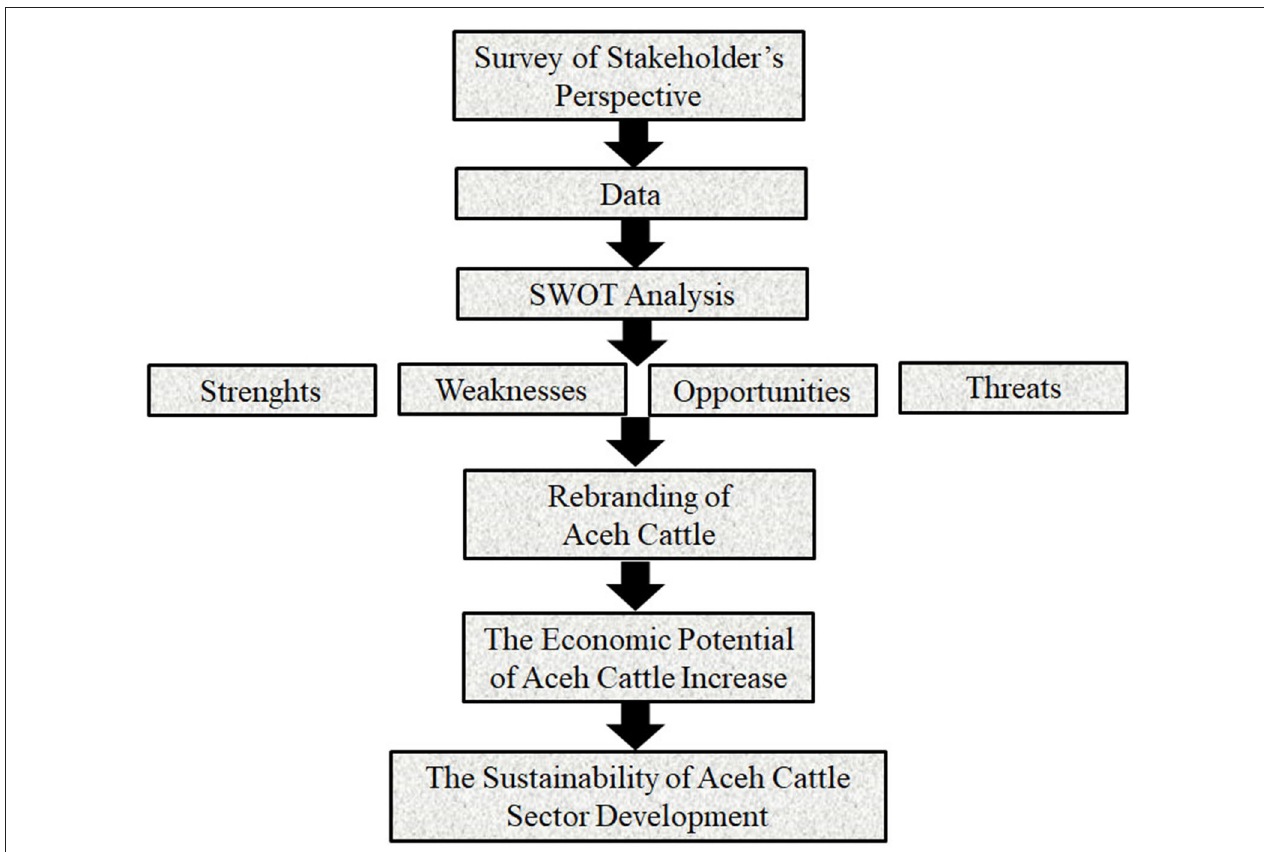
FIGURE 6 | A schematic knowledge framework for increasing the economic potential of Aceh cattle.